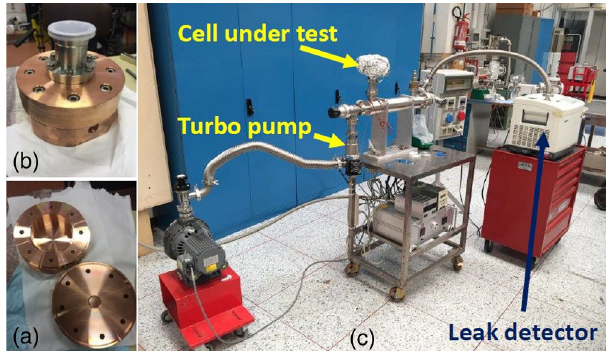
FIG. 13. (a)Cellforthegaskettestbeforeassembly;(b)assembled cell with a gasket; (c) cell under thermal cycle test.